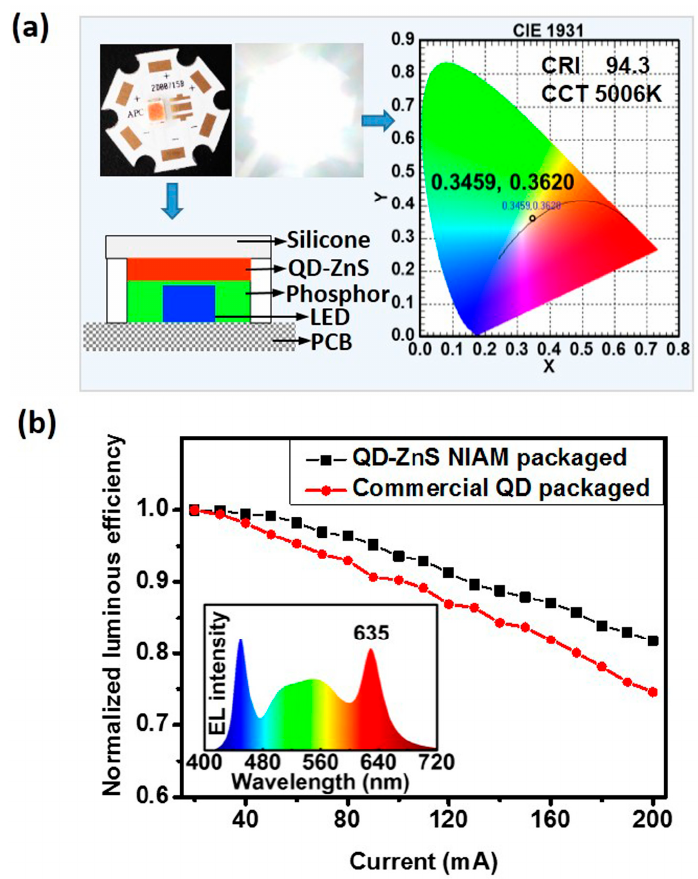
Figure 6. ( a ) The packaging structure of the as-prepared white-LED (WLED) with QD-ZnS NIAM and color information of the WLED prototype; ( b ) Luminous efficiency drop of the QD-ZnS NIAM and the common QD-packaged white-LEDs at different driving currents from 20 mA to 200 mA. (Inserted image shows the EL spectrum of the as-prepared white-LED with QD-ZnS NIAM).